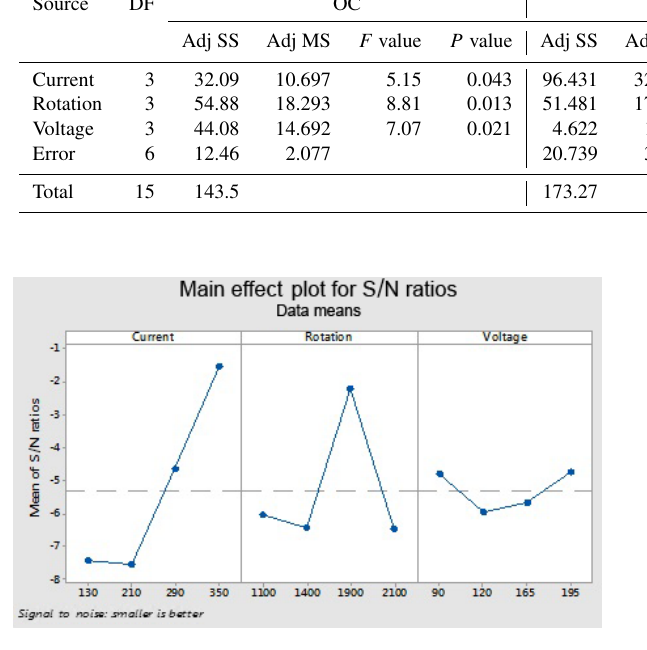
Figure 8. TWR S/N for non-cryogenic tool.